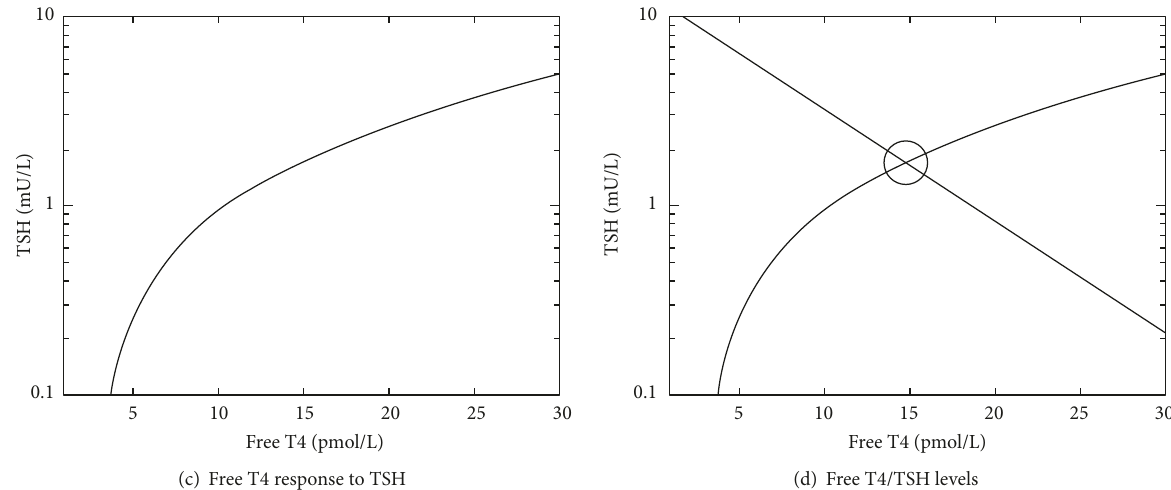
Figure 2: (a) The TSH curve, (b, c) the T4 curve (on different axes, 𝐾 T approx. 41), and (d) the location of the T4/TSH set